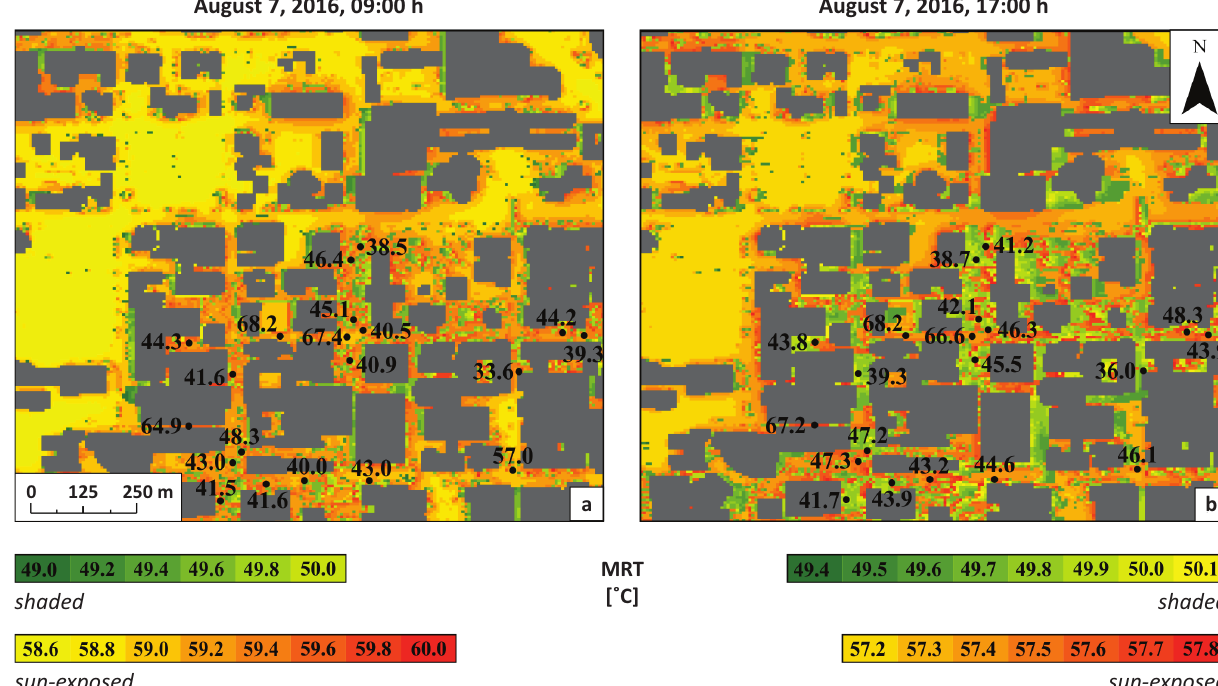
sun-exposed Figure 6. Simulated mean radiant temperature (MRT) map of the study site for 09:00h (a) and 17:00h (b) on August 7, 2016, with on-site mean radiant temperature